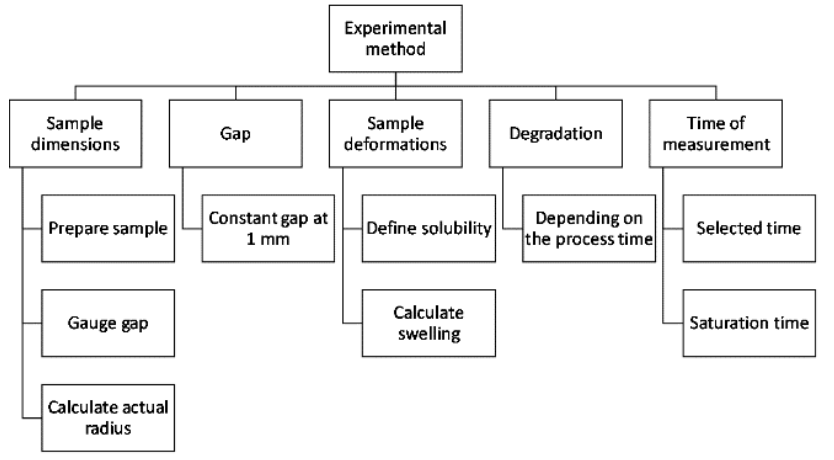
Figure 2. Experimental methodology for this